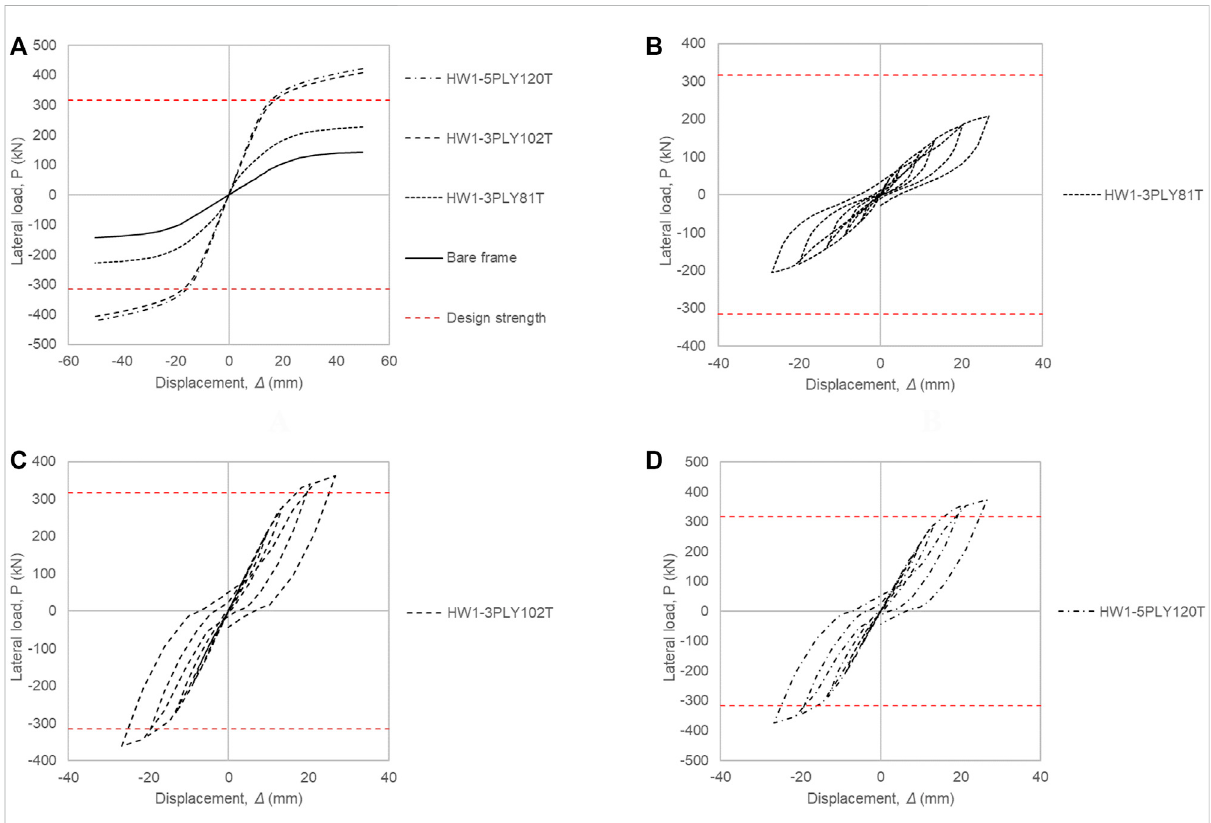
FIGURE 7 Hysteretic and backbone curves of the specimens with frictional in fi ll-frame interface (A) Comparative diagram, (B) 3-ply (81 mm thick), (C) 3-ply (102 mm thick), (D) 5-ply (120 mm thick).